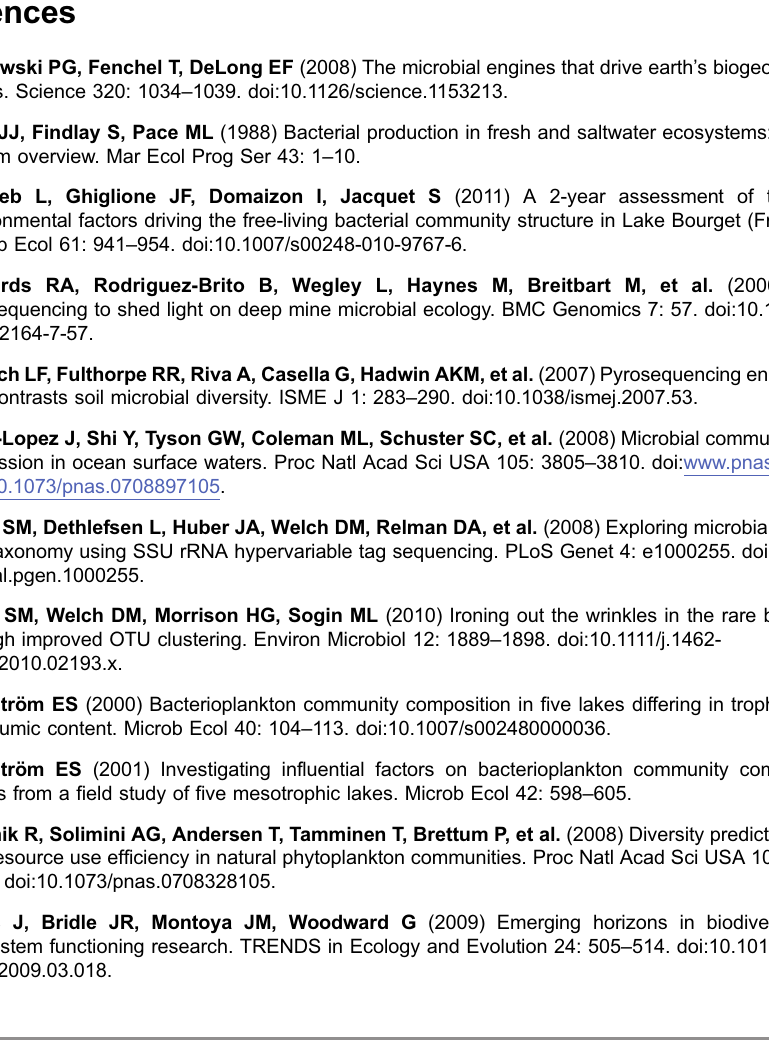
S2 Table. Pearson correlations. Pearson correlation between OTUs (0.03 cut-off level) and environmental factors ( r . 0.85, p ,